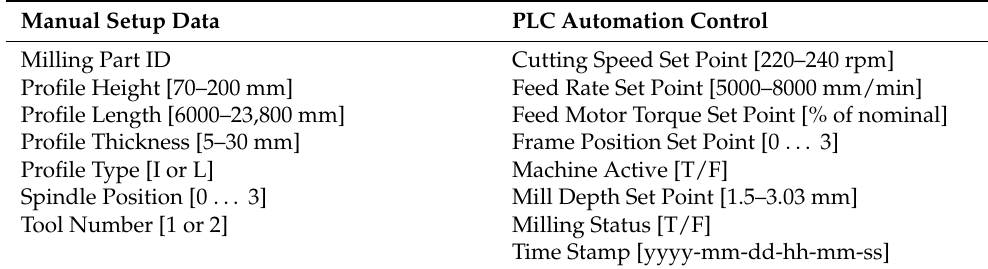
Table 1. Collected data from manual setup data and PLC automation control. Manual Setup